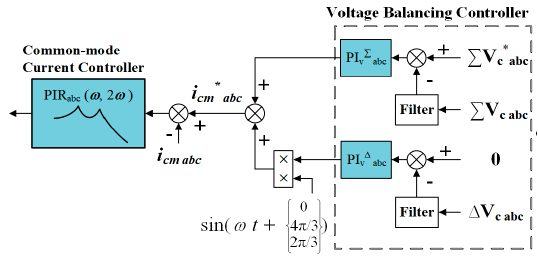
Figure 4. Diagram of the common- and differential-mode capacitor voltage sum controller (Scheme- Figure 4. A) [23].